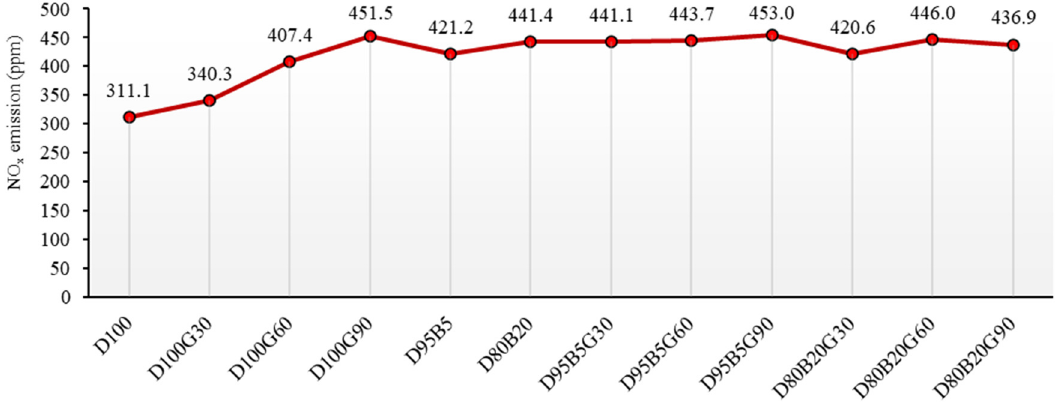
Figure 8: Variations of NO x emission for di ff erent fuel